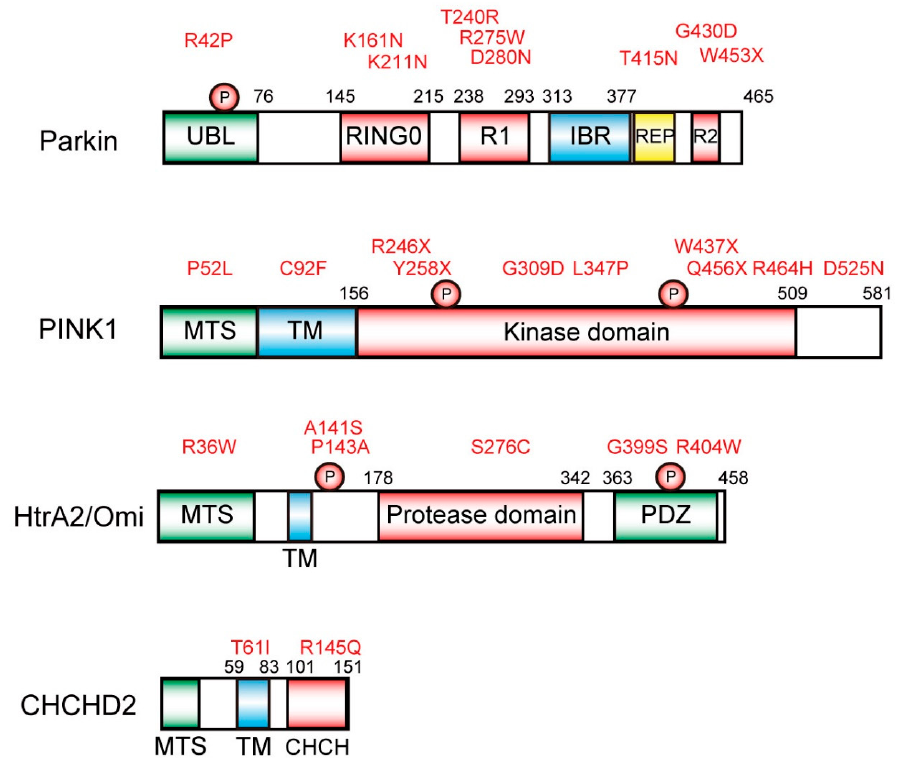
Figure 1. Structures of mitochondrial-localized proteins for genes associated with familial parkinsonism and their phosphorylation sites. The human Parkin, PINK1, HtrA2 / Omi, and CHCHD2 proteins are drawn approximately to scale, with some pathogenic point mutations in red. Parkin contains a UBL domain at the N-terminus followed by three really-interesting-new-gene (RING) finger domains (R0-R2) separated by In-Between-RING fingers (IBR) and repressor element of Parkin (REP) domains. A phosphorylation site for PINK1 occurs at Ser 65 . PINK1 contains an MTS, transmembrane domain (TM), the kinase domain, and C-terminal sequences of uncertain function. Autophosphorylation sites are at Ser 228 and Ser 402 . HtrA2 / Omi consists of an MTS, TM, and a conserved catalytic trypsin-like serine protease domain, and a C-terminal PSD-95 / Dlg / ZO-1 (PDZ) domain. Ser 142 is phosphorylated by p38 in a PINK1-depedent manner and Ser 400 is phosphorylated by CDK5. CHCHD2 has an MTS, TM, and CHCH domain. The CHCH domain consists of twin CX(9)C motifs and two disulfide bonds that stabilize the CHCH fold.